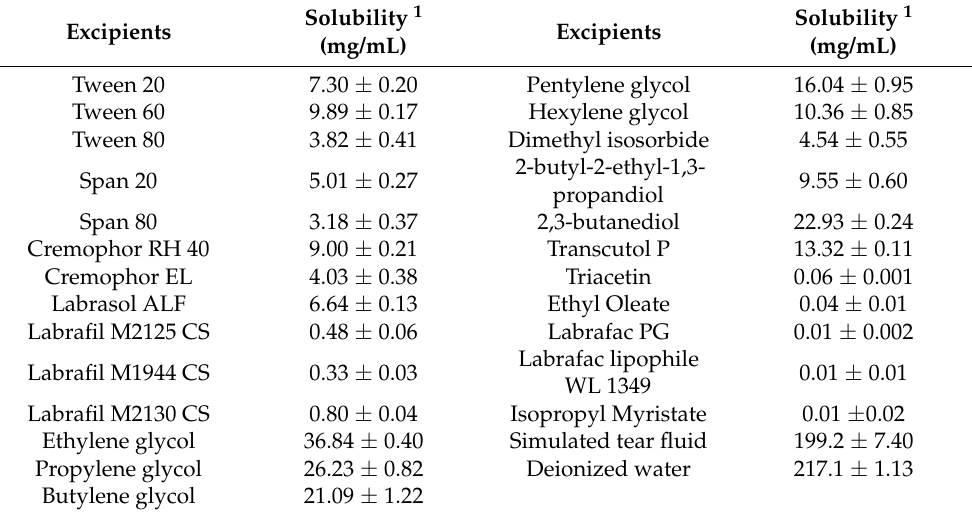
Table 5. Saturation solubility of KT in different excipients (surfactants, cosurfactants, oils, deionized water, and simulated tear